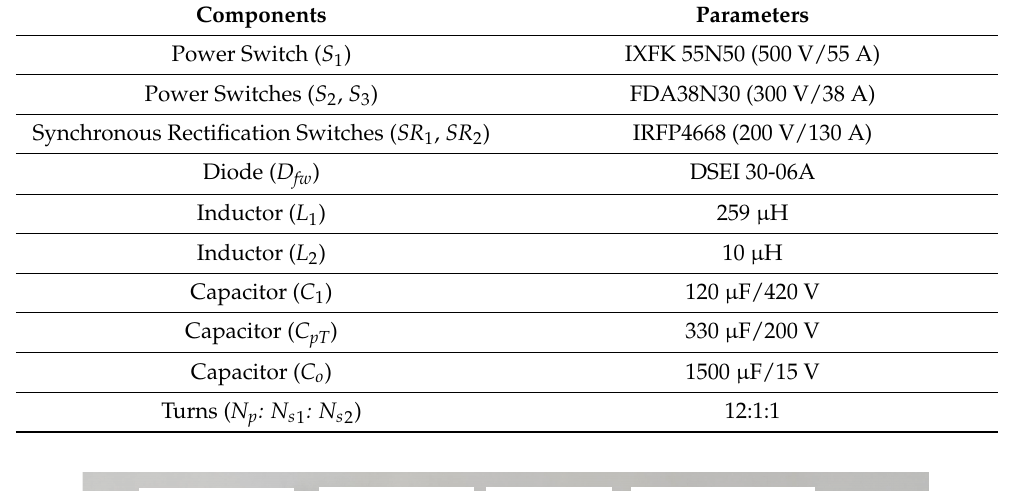
Table 2. The component parameters of the proposed topology.